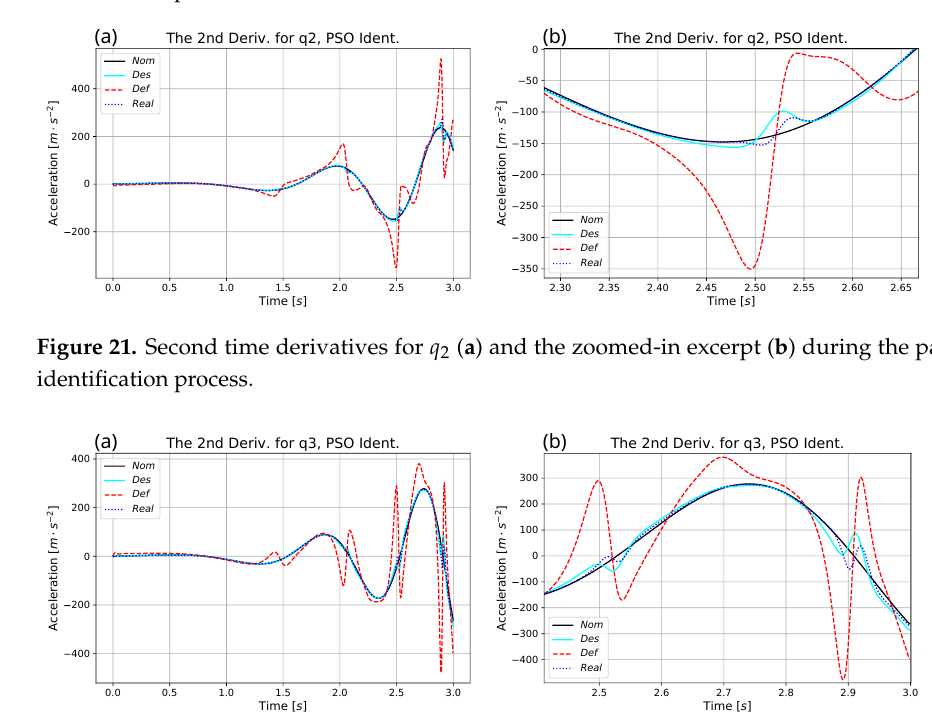
Figure 20. Second time derivatives for q 1 ( a ) and the zoomed-in excerpt ( b ) during the parameter identification process.